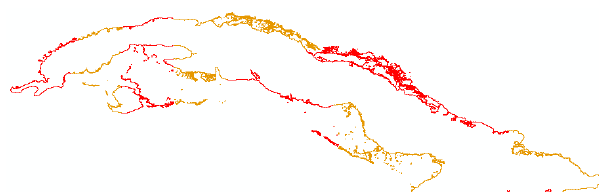
Figure 11. Results of the vectorization of the Cuban archipelago